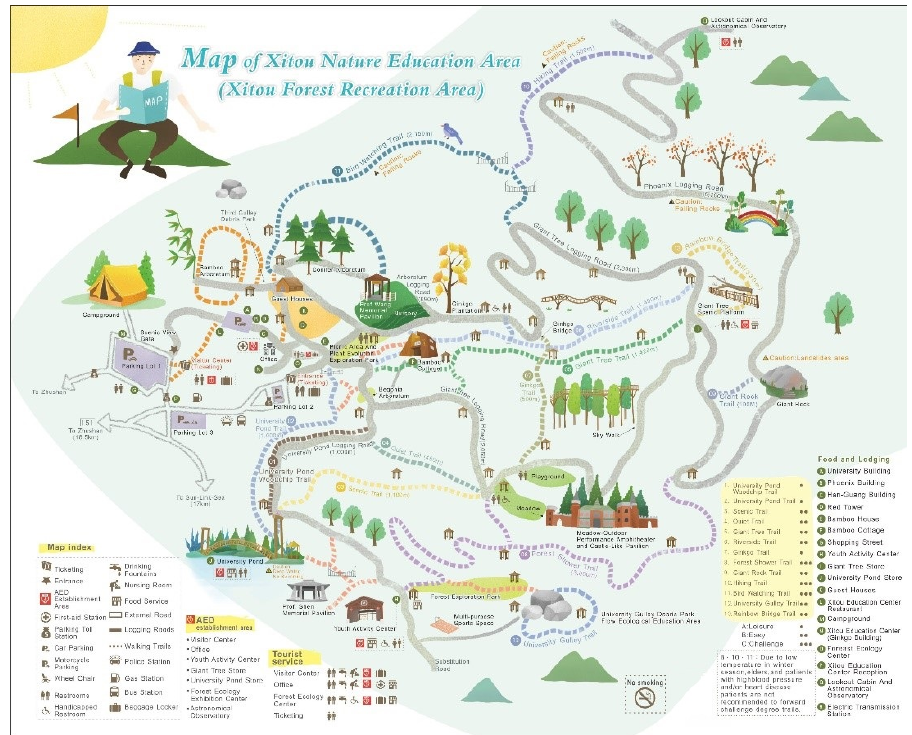
Figure 2. Map of Xitou Nature Education